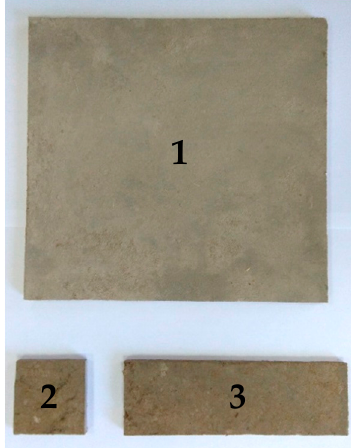
Figure 2. Specimens for the different tests. 1 (300 × 300 mm 2 ), 2 (50 × 50 mm 2 ), 3 (150 × 50 mm 2 ).